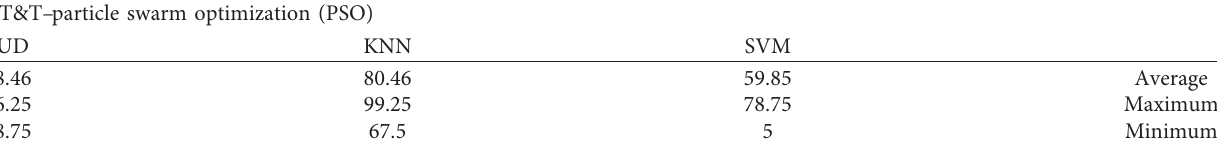
Table 5: Recognition accuracies for the AT&T database with the PSO algorithm.